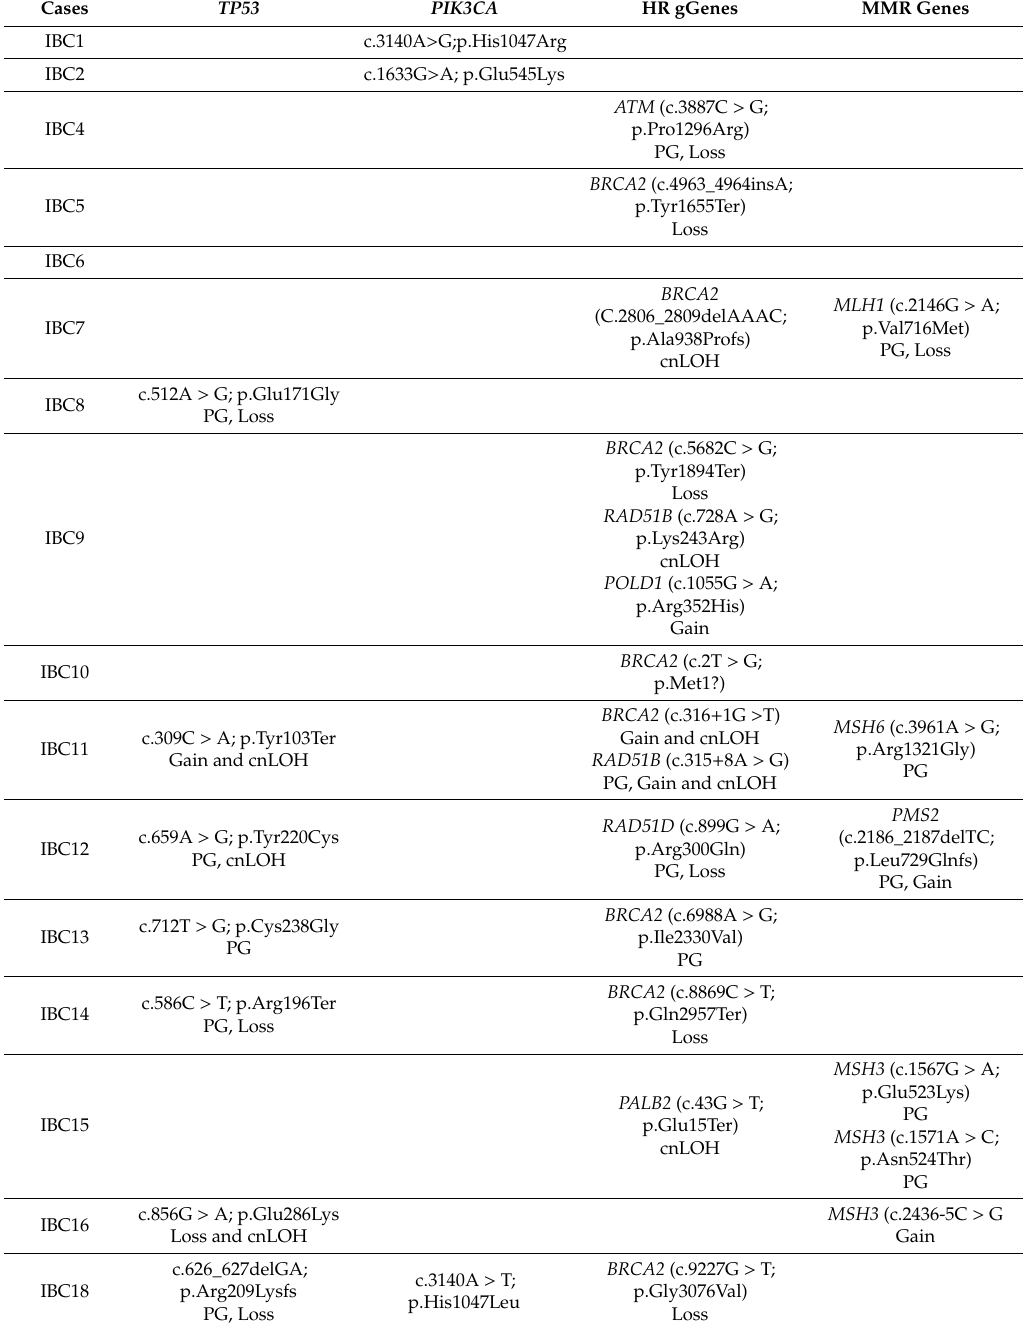
Table 2. Genetic variants found in TP53 , PIK3CA, homologous recombination (HR), and mismatch repair (MMR) genes detected in 21 inflammatory breast carcinomas assessed by tNGS